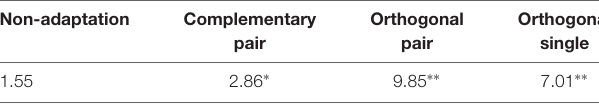
TABLE 1 | Z -scores for 3 Hz signals in each condition, over the ROT